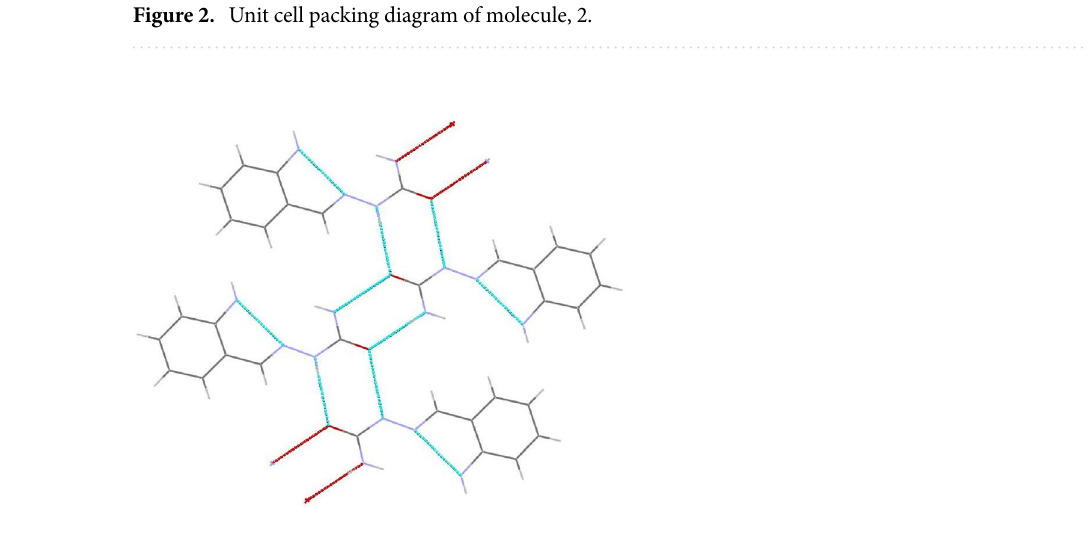
Figure 3. Structure of molecule 2 with hydrogen bonds.